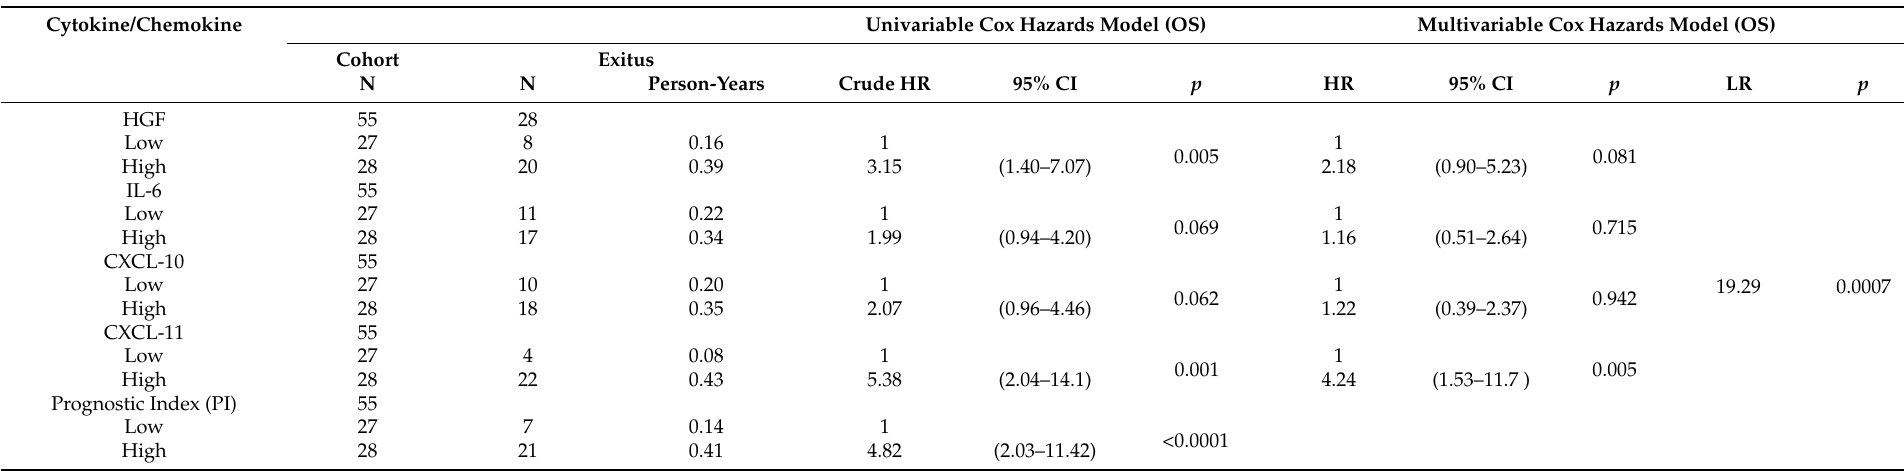
Table 4. Univariable and multivariable Cox proportional-hazards model for